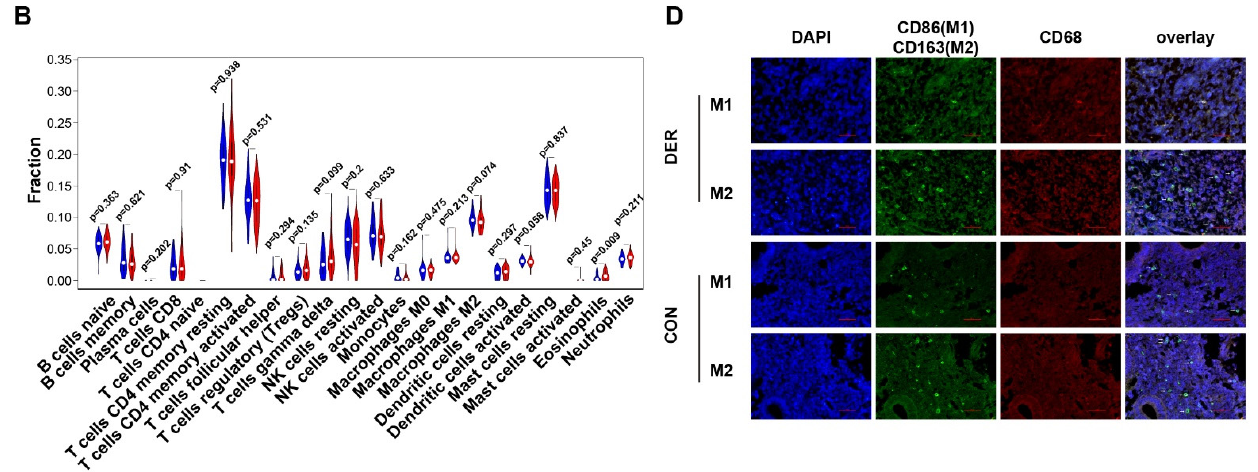
Figure 2. Immune infiltration analysis and M1 to M2 macrophage ratio. ( A ) Bar plots for 22 immune cells in endometrial mixed tissue samples. ( B ) Violin plots for immune cells in DER and control groups. Blue colour represents the DER group while the red colour represents the control group. ( C ) Comparisons of M1/M2 between the DER and control groups from the GSE58144 dataset. Values are presented as medians (ranges). ( D ) Immunofluorescence detection of M1 and M2 macrophages. CD86 (green) and CD68 (red) positivity represent M1. CD163 (green) and CD68 (red) positivity represent M2. White arrows in the overlay represent positive cells. ( E ) Immunofluorescence validation of M1/M2 comparisons in the DER ( n = 13) and control ( n = 10) groups. Values are presented as medians (ranges). DER = Defective Endometrial